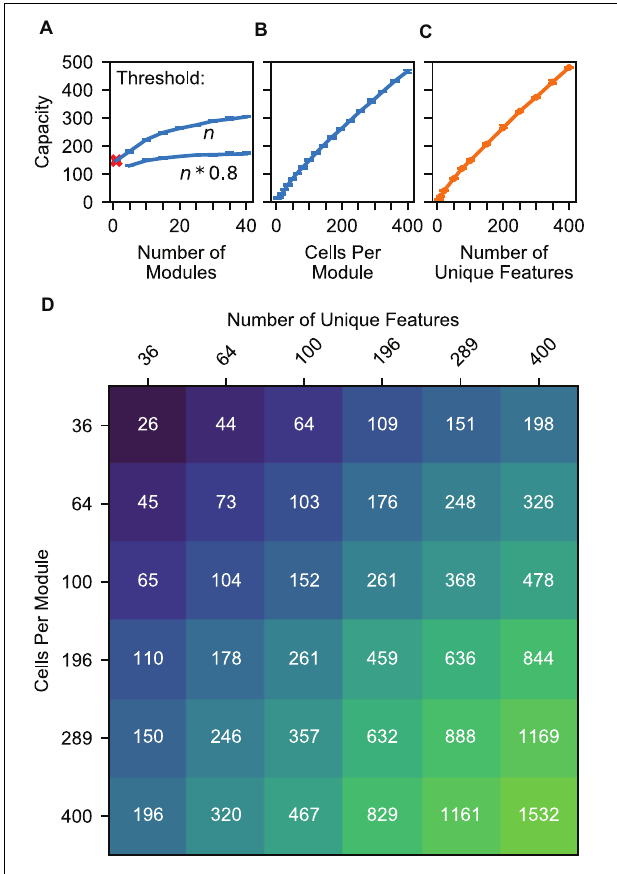
FIGURE 8 | (A–C) Model capacity changes with model parameters (blue) and object parameters (orange). The network’s capacity is the maximum number of objects that it can learn while maintaining the ability to uniquely identify at least 90% of the objects. We repeat the experiment with 10 different sets of random objects and we plot the 5th and 95th percentiles of each capacity. (A) Increasing the number of modules in the network increases capacity sublinearly, and this impact depends on the dendritic threshold of the neurons reading this location representation. The two lines show two different thresholds relative to n , the number of modules. With only one module, the network can successfully converge to one location, but that location is not object-specific (red ‘x’). (B) Increasing the number of cells increases capacity linearly. (C) Similarly, increasing the feature pool size also increases capacity linearly. (D) A heatmap showing the capacity of the network while varying the feature pool size and location module size. An increase in the number of cells per module can compensate for a decrease in the number of unique